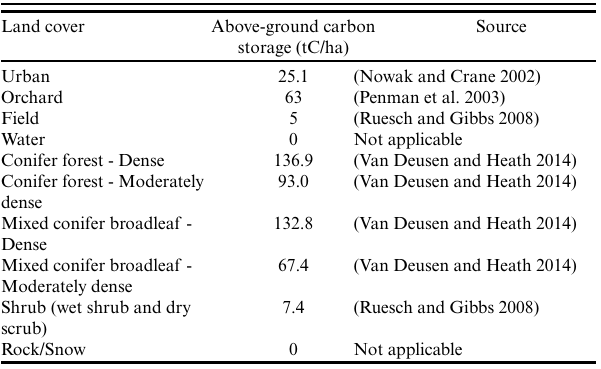
Table 2 . Above-ground carbon storage for different land-cover